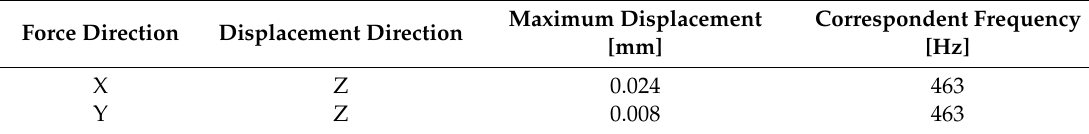
Table 4. Maximum distancing of slots sections.